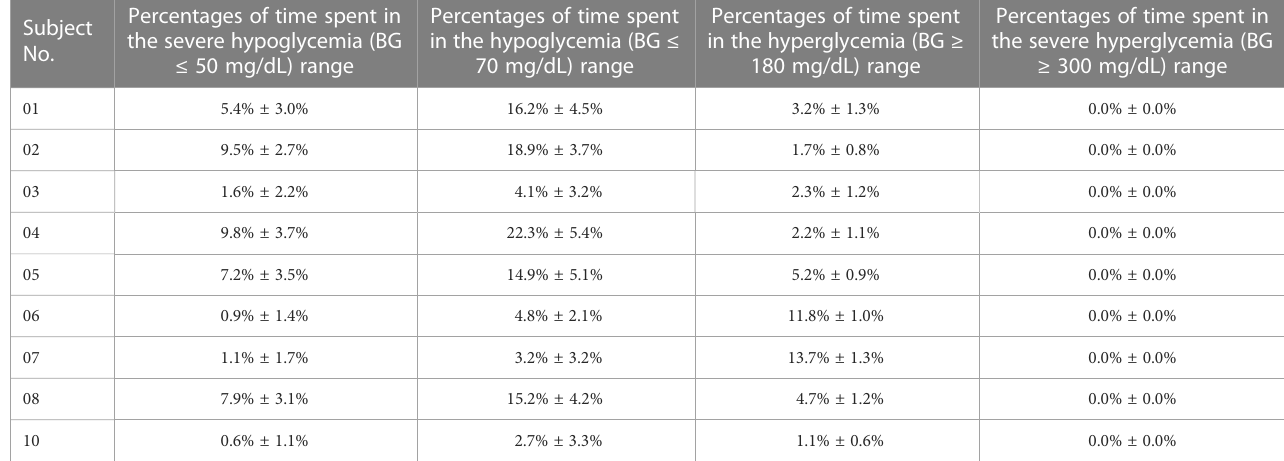
TABLE 3 Percentages of time spent in the severe hypoglycemia (BG ≤ 50 mg/dL) range, the hypoglycemia (BG ≤ 70 mg/dL) range, the hyperglycemia range (BG > 180 mg/dL), and the severe hyperglycemia range (BG > 300 mg/dL) of each in-silico subject with the GPC+AW controller. Percentages of time spent in the severe hypoglycemia (BG